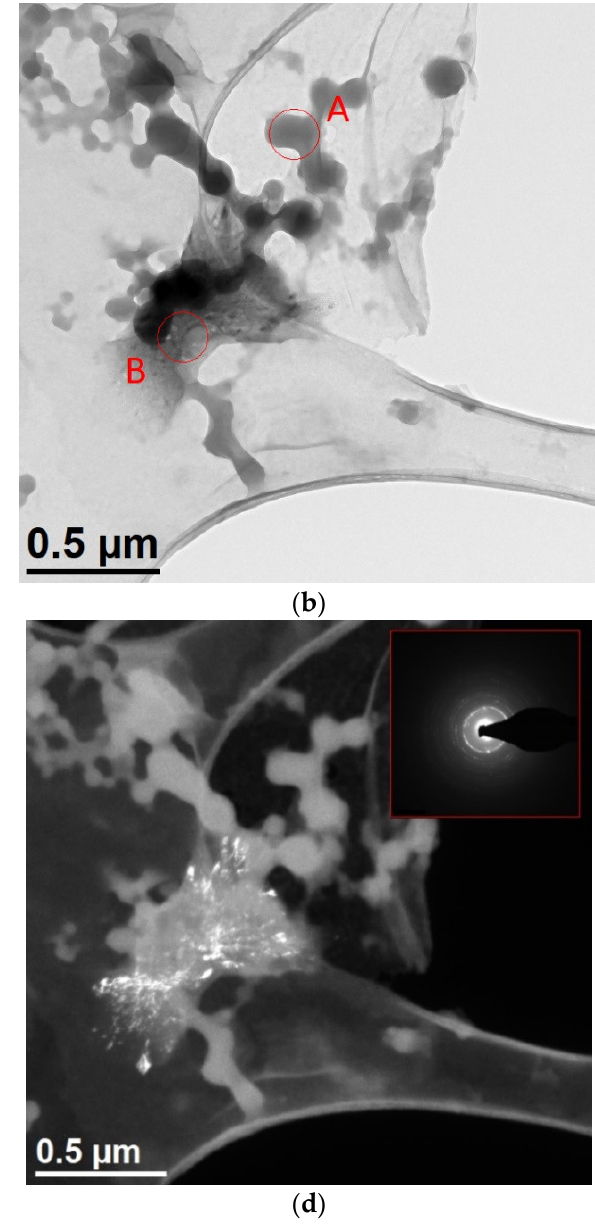
Figure 5. Microscope images of the dried residues precipitated from leachate; ( a ) undiluted (STEM HAADF—High-angle annular dark-field scanning transmission electron microscopy), ( b ) diluted (TEM), ( c ) selected area diffraction SAED obtained for area indicated by A image ( b ), ( d ) dark field image (TEM-DF), in right bottom part selected area electron diffraction from the area indicated by B in image ( b ).